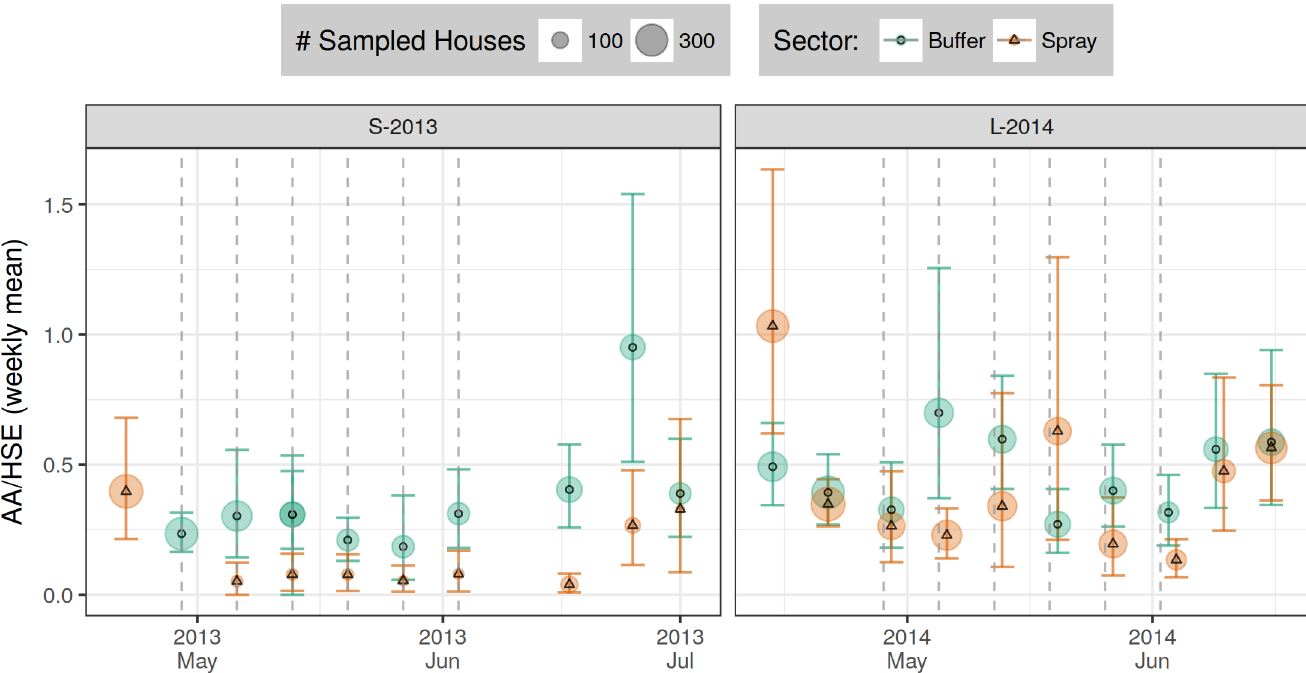
Fig 6. Detailed time series of AA/HSE response to ULV spraying, aggregated by week. X-axis shows week start date. Color and symbol shape shows sector (orange triangle: spray sector). Point size shows number of surveyed houses. Vertical dashed lines show approximate dates of experimental spraying (spray sector only). Vertical colored bars show bootstrap 95% CI (1e+04 draws per